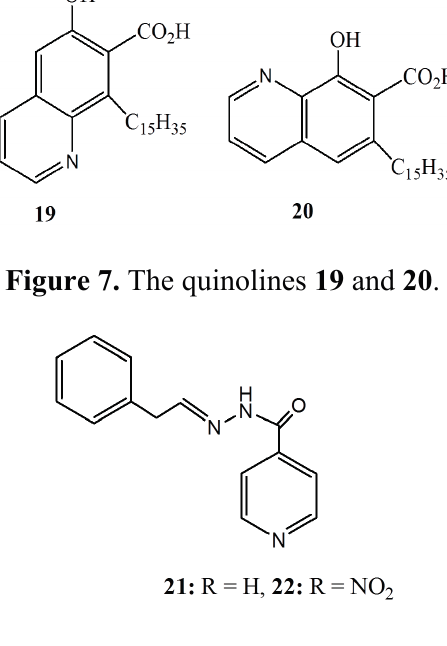
Figure 8. The isonicotinoylhydrazones 21 and 22